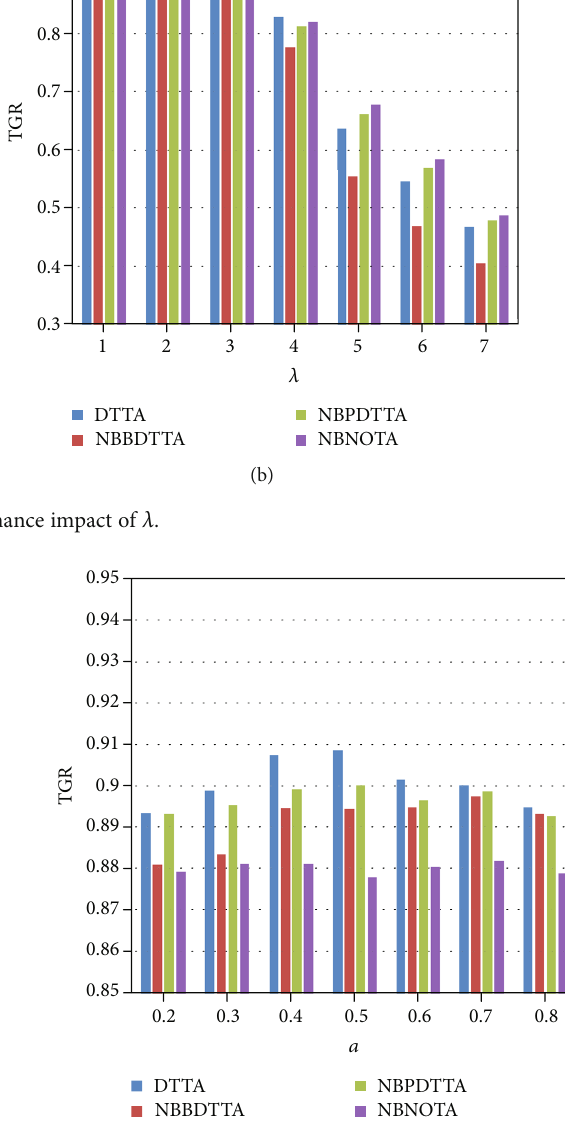
12: Performance impact of et threshold